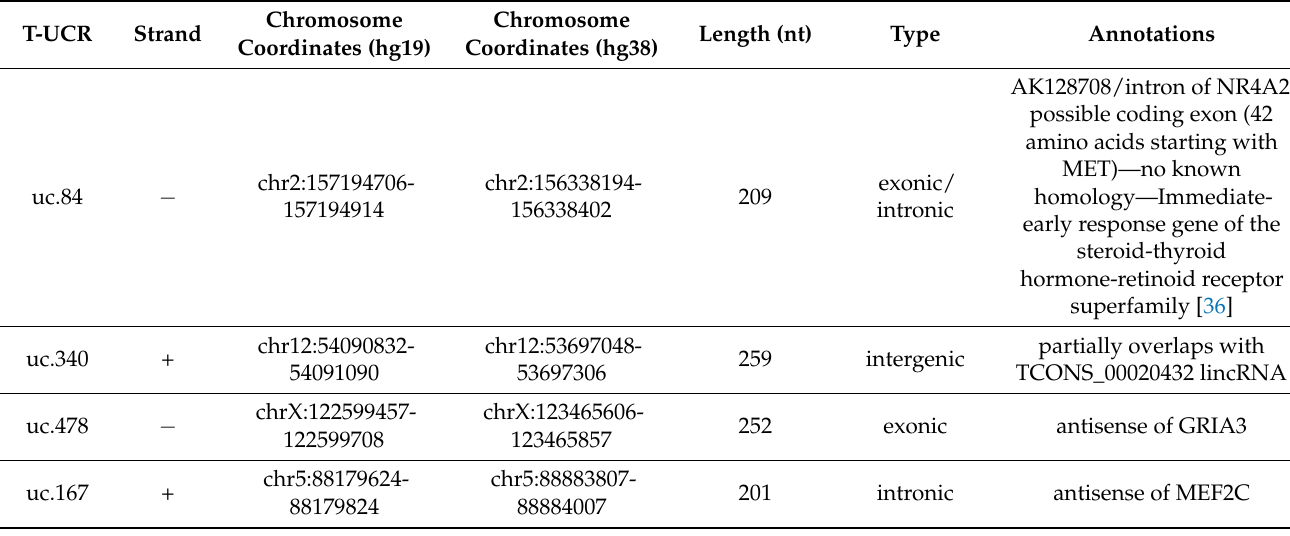
Table 2. Genomic coordinates and characteristics of T-UCRs, candidate alternatives/antagonists of